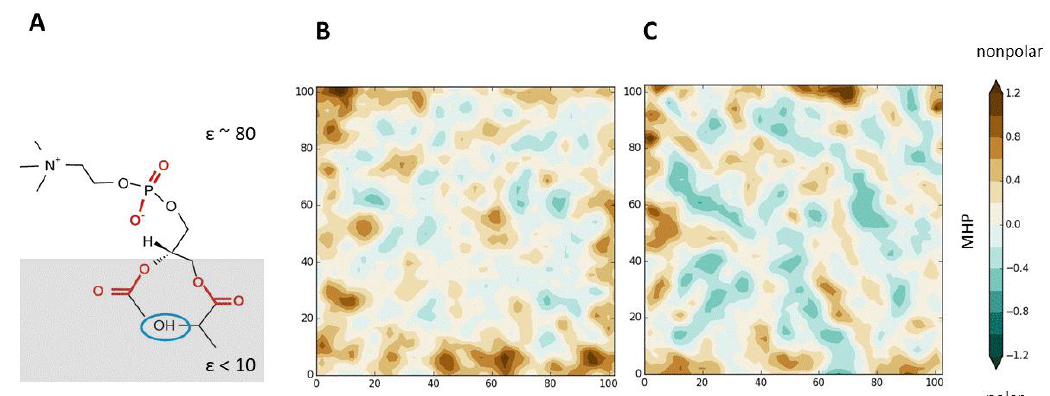
Figure 1. ( A ) Schematic representation of location of sn-1-β-hydroxy-dioleoylphosphatidylcholine molecule (DOPC-oh) with respect to the membrane. The low-dielectric part of the membrane is gray hatched. Only polar head of DOPC-oh is shown. Engineered H-bond donor is blue circled. H-bond acceptors are given in red. ε is the dielectric permittivity. ( B,C ) Hydrophobic/hydrophilic organization of the surfaces of DOPC ( B ) and DOPC-oh ( C ) bilayers (according to [49,74]). In-plane projections of the distributions of the molecular hydrophobicity potential (MHP) values over the solvent accessible surface of lipid bilayers (2D-maps of MHP). MHP values are calculated in each point of the surface. The maps are given for one of the bilayer leaflets. Bilayer snapshots are extracted form MD trajectories of the corresponding bilayers. Coloring scheme for MHP is shown on the right. MHP values are given in octanol-water log p units.